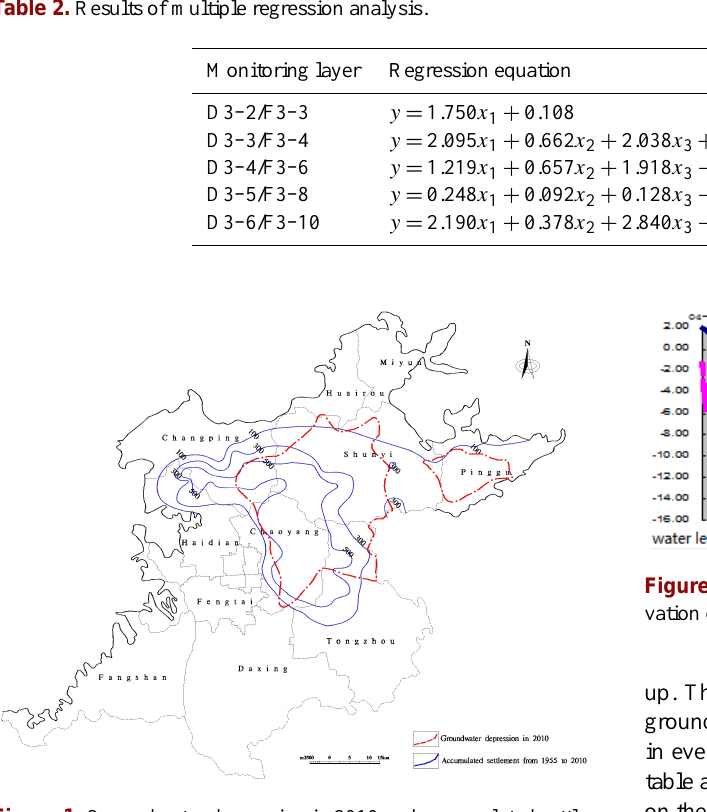
Figure 1. Groundwater depression in 2010 and accumulated settle- ment from 1955 to 2010.